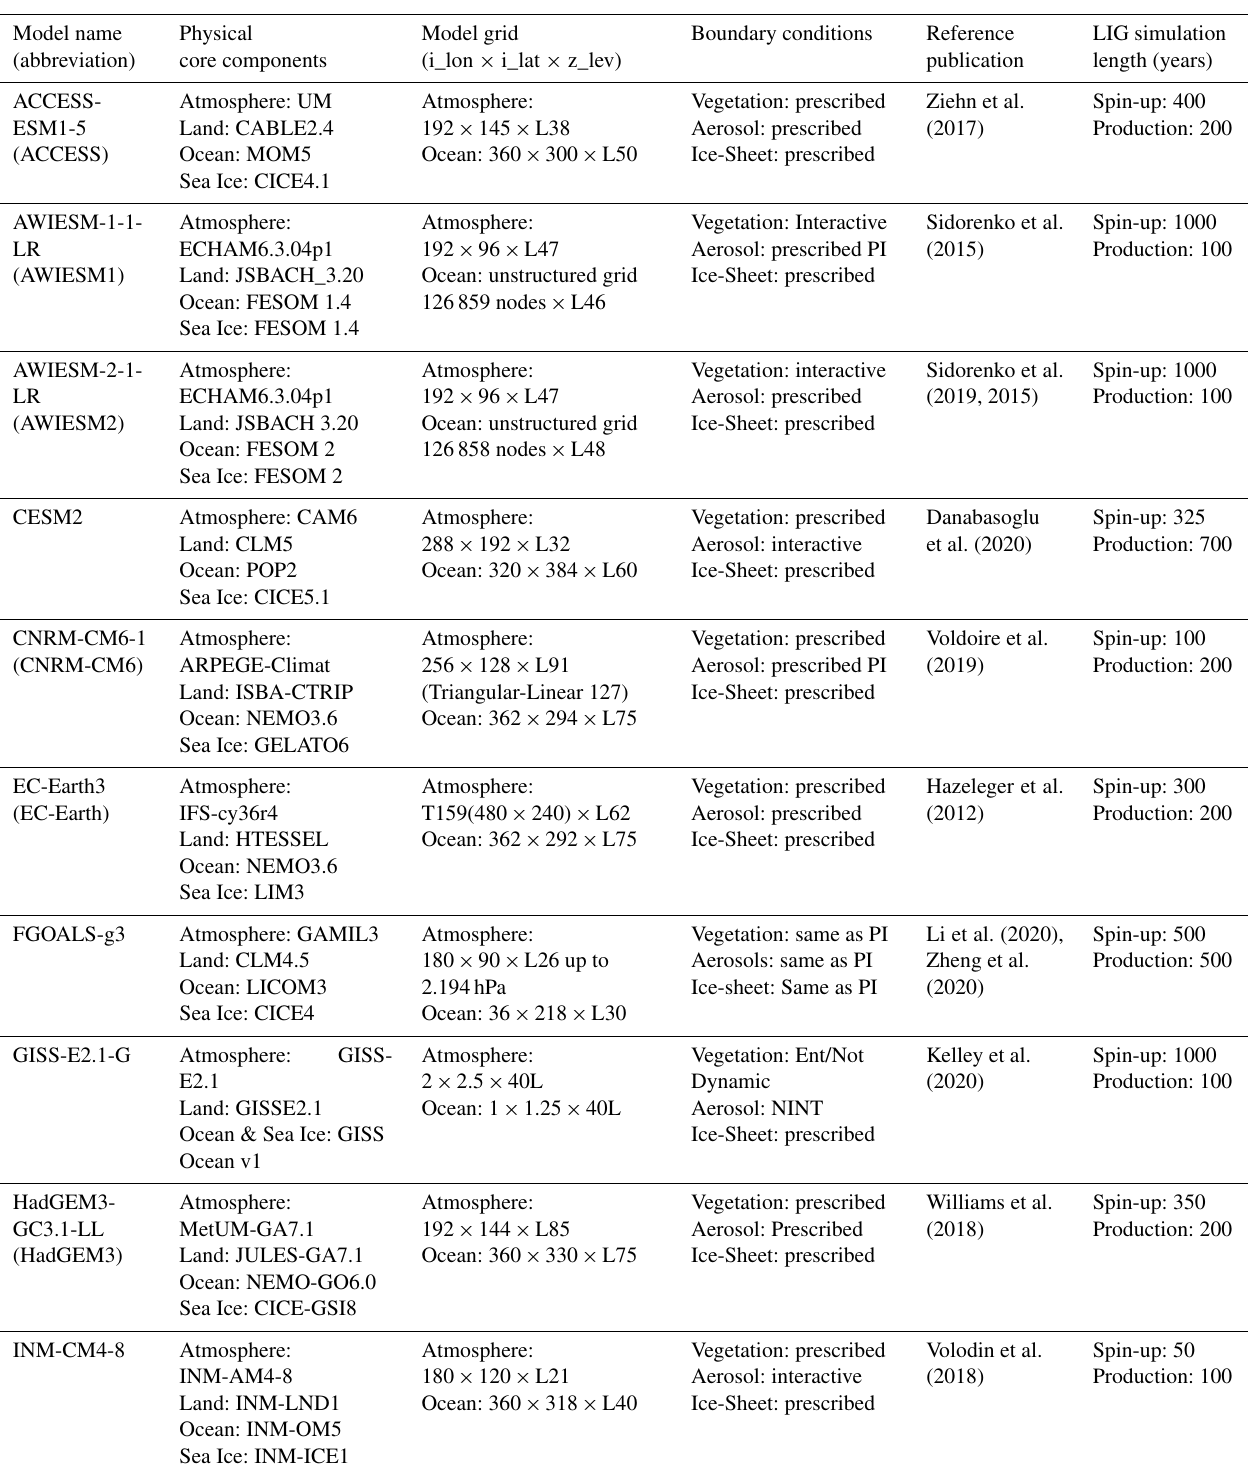
Table 2. Overview of models that have run the CMIP6-PMIP4 LIG simulation. For each model, denomination, physical core components, horizontal and vertical grid specifications, details on prescribed vs. interactive boundary conditions, reference publication, and LIG simulation length are